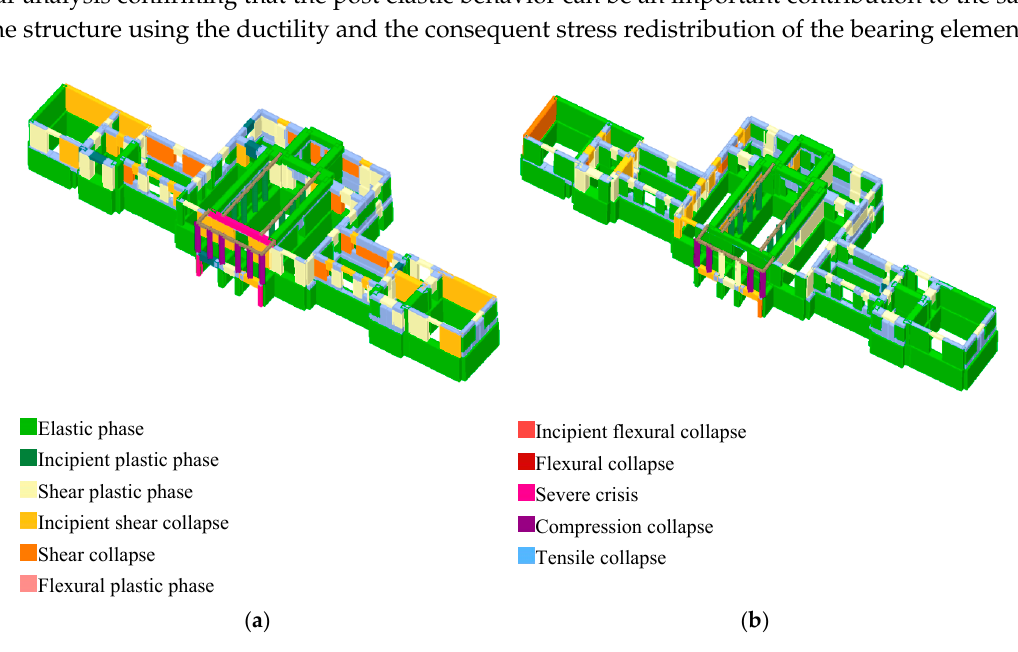
Table 3. Results related to the worst load conditions deriving from pushover analysis.